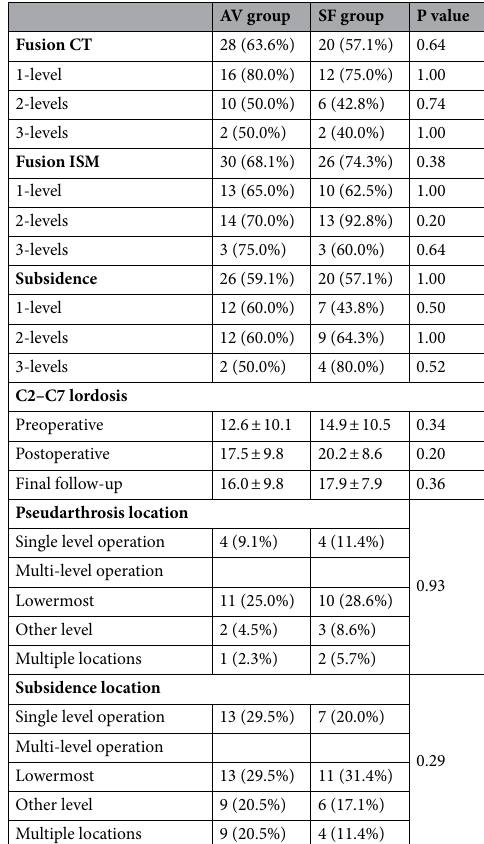
Table 2. Radiographic results. Fusion, subsidence, location of pseudarthrosis, and location of subsidence were analyzed using a chi-square test. C2–C7 lordosis was analyzed using a student’s t-test. AV all variable, SF selective fixed, ISM interspinous motion. *P < 0.05.